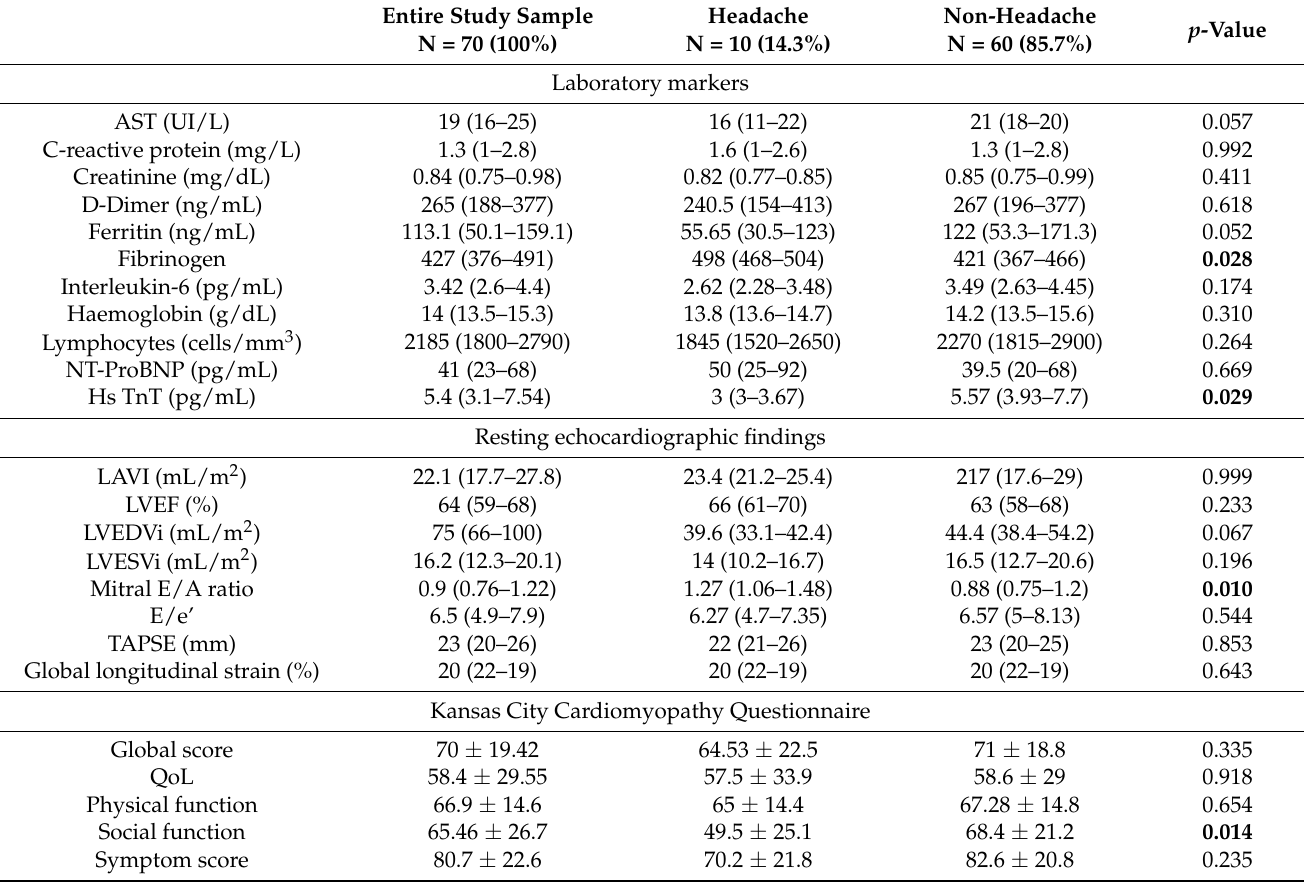
Table 2. Follow-up complementary test of patients according to the presence or absence of long- COVID headache during